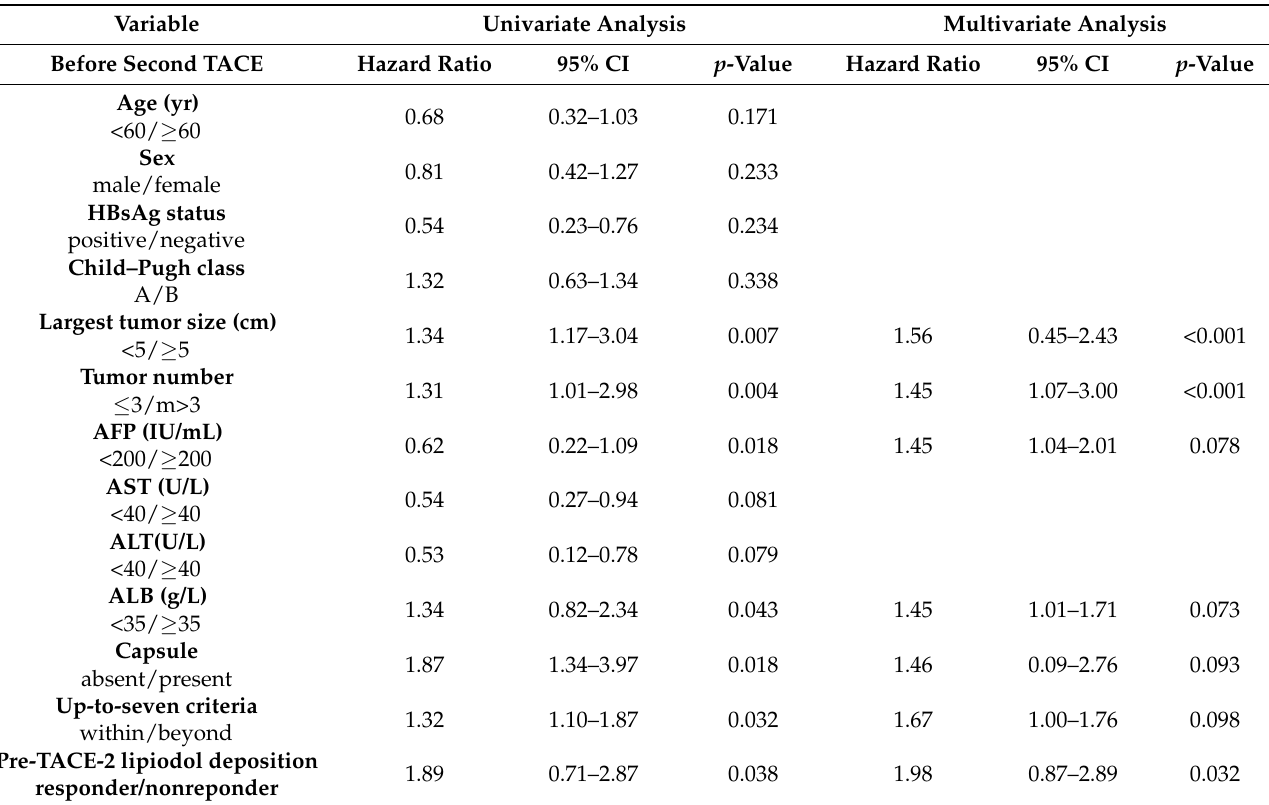
Table 4. Predictors of death for patients with intermediate-stage HCC before second TACE.